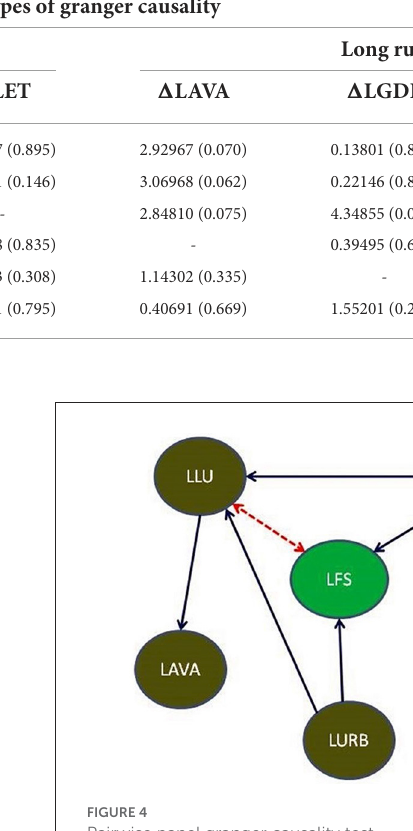
TABLE 9 Pairwise panel causality test.